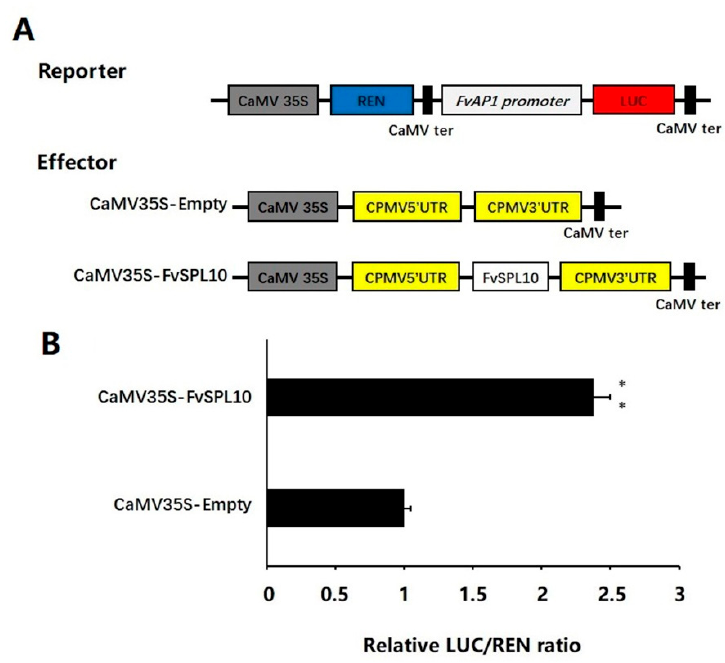
Figure 4. FvSPL10 directly activates the expression of FvAP1 . ( A ) Schematic representation of the reporter and e ff ector constructs used in this study. LUC, firefly luciferase; REN, renilla luciferase. ( B ) FvSPL10 activates the promoter of FvAP1 . The activation was calculated by the ratio of LUC / REN between sample and control. The ratio of LUC / REN of empty vector together with FvAP1 promoter was used as a calibrator (set to 1). Each value represents the means of six biological replicates. Double stars represent a significant di ff erence between the sample and control at p < 0.01, based on the Student’s t -test.